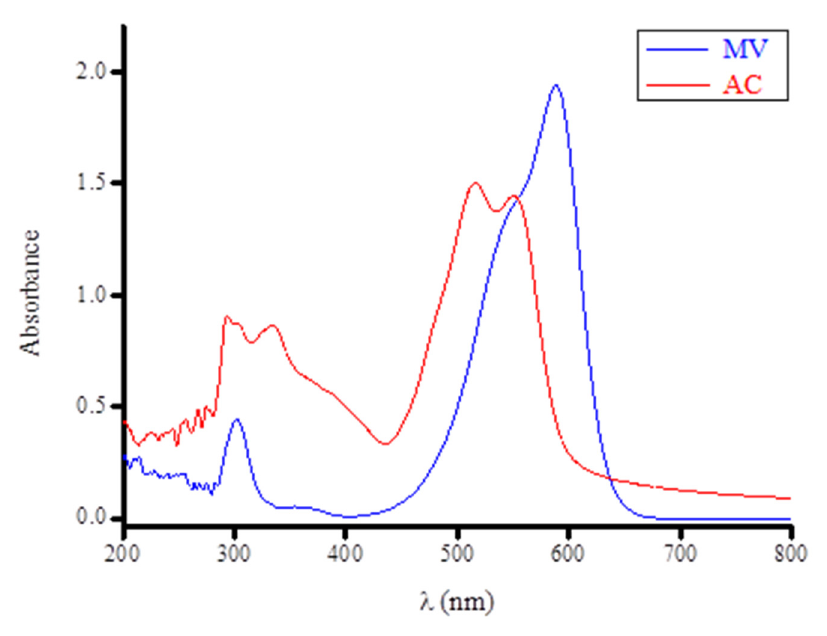
Figure 12. Electronic spectra of MV and AC in aqueous solution (pH = 7) (0.005 g of the dye content dissolved in 100 mL of deionized water).